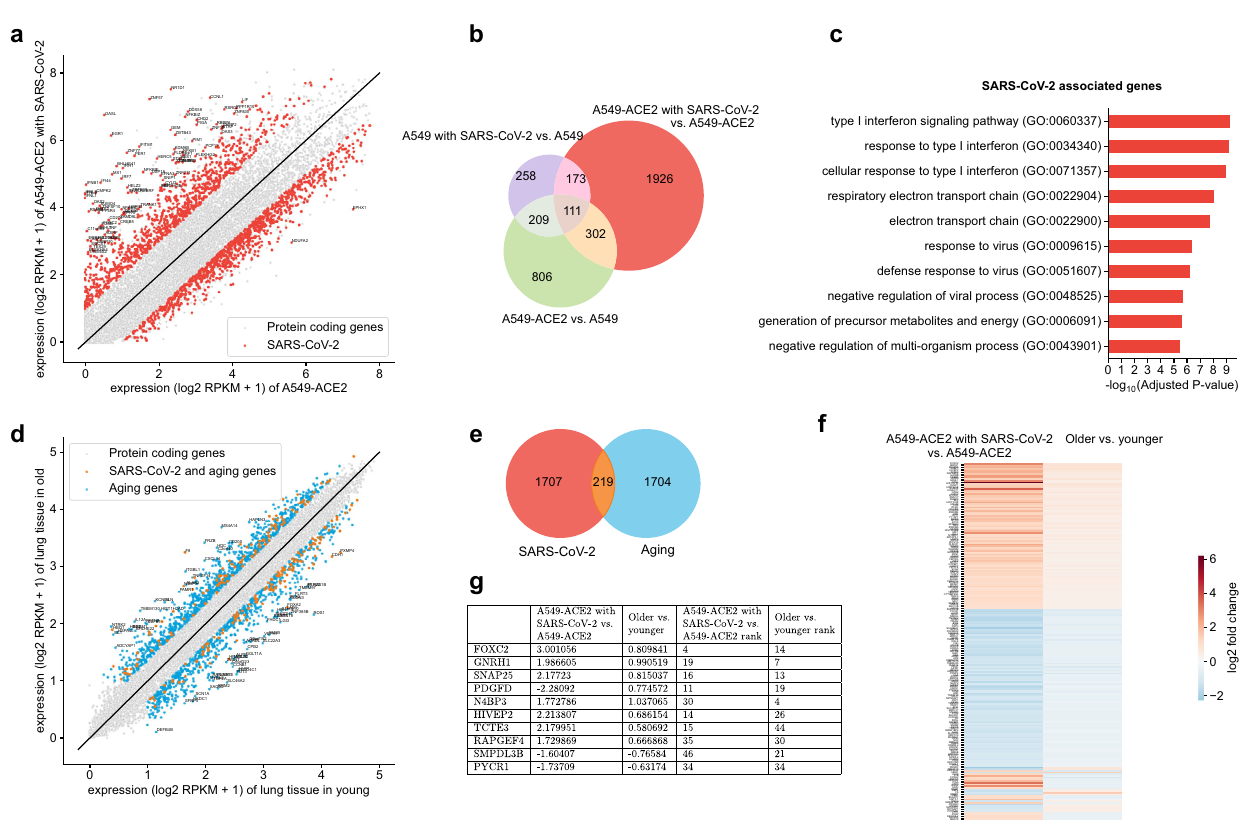
Fig. 2 Identi fi cation of differentially regulated genes in SARS-CoV-2 infection and aging. a Gene expression (log 2 RPKM + 1) of A549-ACE2 cells infected with SARS-CoV-2 versus normal A549-ACE2 cells. Genes associated with ACE2-mediated SARS-CoV-2 infection after removing just ACE2- speci fi c or just SARS-CoV-2 infection-speci fi c genes are shown in red with the remaining protein-coding genes shown in gray. b Venn diagram, showing the number of genes in sets considered for obtaining the 1926 genes in the red subset and shown in red in ( a ) associated with ACE2-mediated SARS-CoV- 2 infection. Purple, red, and green whole circles indicate differentially expressed genes associated with A549 cells infected with SARS-CoV-2, A549-ACE2 cells infected with SARS-CoV-2, and A549 cells with and without ACE2, respectively. c Top ten gene ontology terms associated with SARS-CoV-2 infection (adjusted p value < 0.05, Benjamini – Hochberg procedure). d Gene expression (log 2 RPKM + 1) of cells collected from lung tissue of older (70 – 79 years old) versus younger (20 – 29 years old) individuals. Differentially expressed genes associated with aging are shown in blue and genes that are associated with both aging and SARS-CoV-2 are shown in orange with the remaining protein-coding genes shown in gray. e Venn diagram of genes associated with SARS-CoV-2 (red circle) and aging (blue circle); intersection (orange) is signi fi cant ( p value = 0.01999, one-sided Fisher ’ s exact test). f Heatmap of log 2 -fold changes of differentially expressed genes shared by SARS-CoV-2 and aging; most genes show concordant expression, i.e., they are both upregulated or both downregulated with SARS-CoV-2 infection and aging. g Table of the top ten most differentially expressed genes across aging and SARS-CoV-2, based on the sum of their ranks with log 2 -fold changes for each